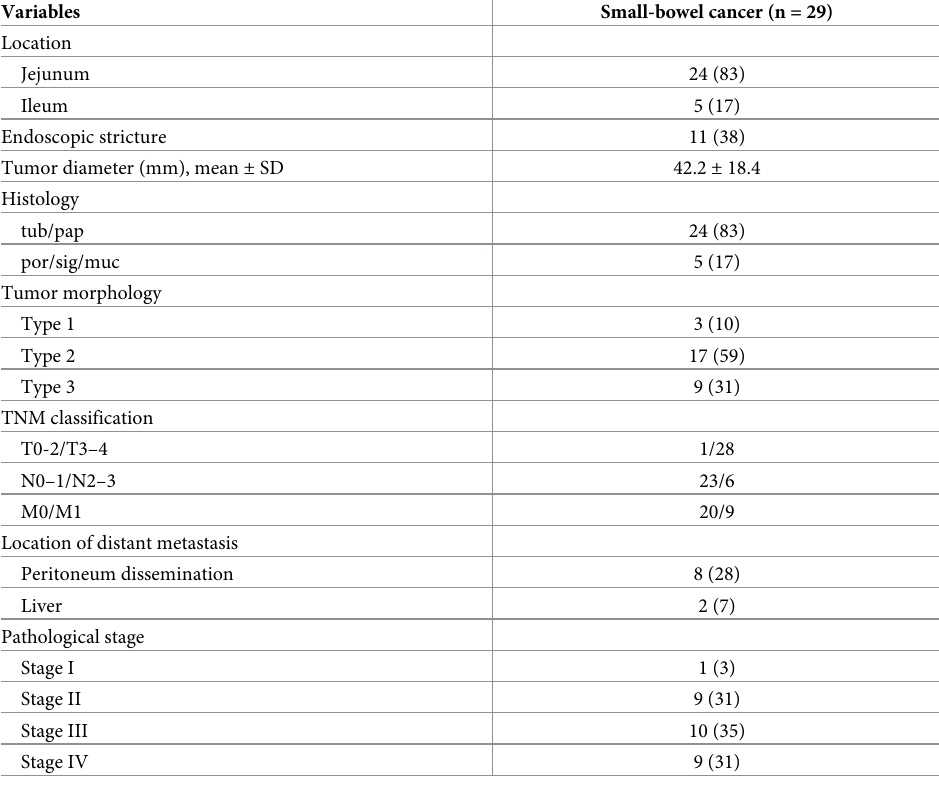
Table 2. Baseline characteristics of small-bowel cancer. Characteristics of small-bowel cancer lesions in our